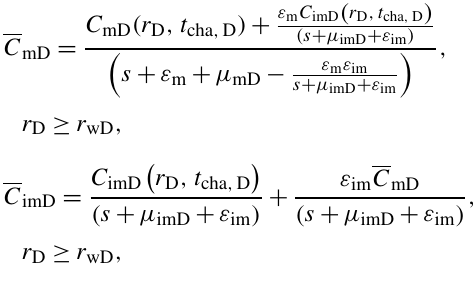
For the rest phase, the solutions of the SWPP test in the Laplace domain